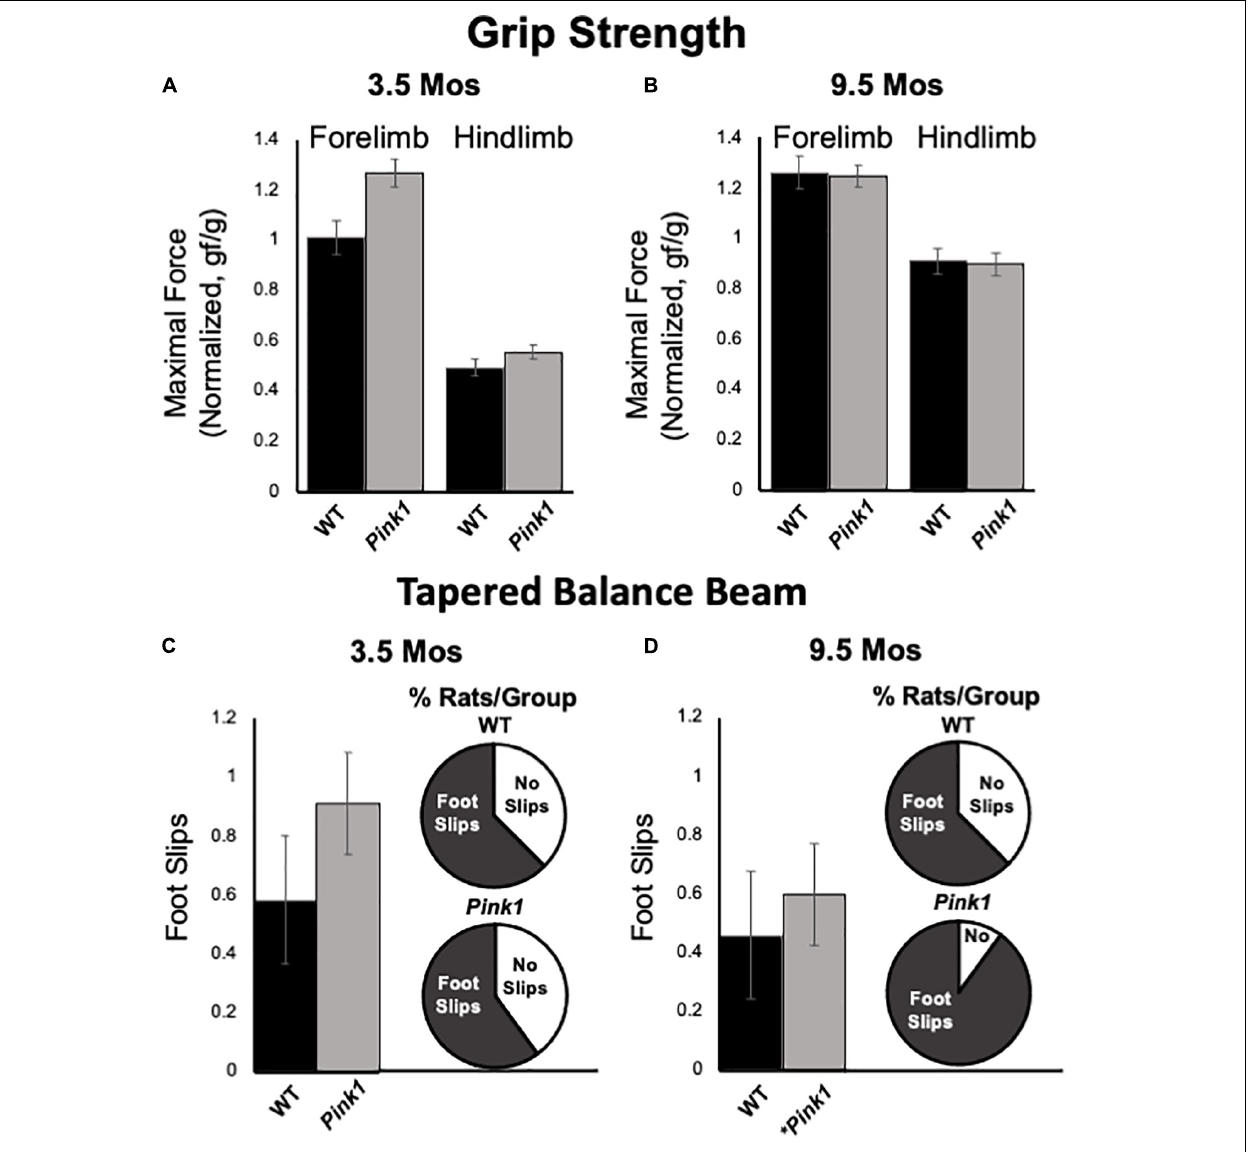
FIGURE 9 | Grip Strength and Tapered Balance Beam data. Bar graphs showing measures of maximum forelimb (A) and hindlimb (B) grip strength/force normalized to body mass [grams of force (gf)/body weight in grams (g)] in wild type (WT, black bars) and rats with knockout of the PTEN (phosphatase and tensin homolog)-induced putative kinase1 gene ( Pink1–/–, gray bars) measured at 3.5 and 9.5 months (mos) of age. There were no significant group differences in these measures of muscle strength at either age. Bar graphs showing average total numbers of foot slips committed by WT (black bars) or Pink1 –/– rats (gray bars) in tapered balance beam traversal trials at 3.5 (C) and 9.5 (D) mos of age. Pie graph inserts show the proportion/percent of rats in each group that did or did not commit foot slips during the trial. Numbers of foot slips were minimal in both groups at both ages. However, proportionally more Pink1 –/– rats made foot slips compared to WT rats at 9.5 mos of age. The asterisk on the X -axis (D) denotes that five rats in the Pink1 –/– group were removed from testing at 9.5 mos of age due to inability to cross the